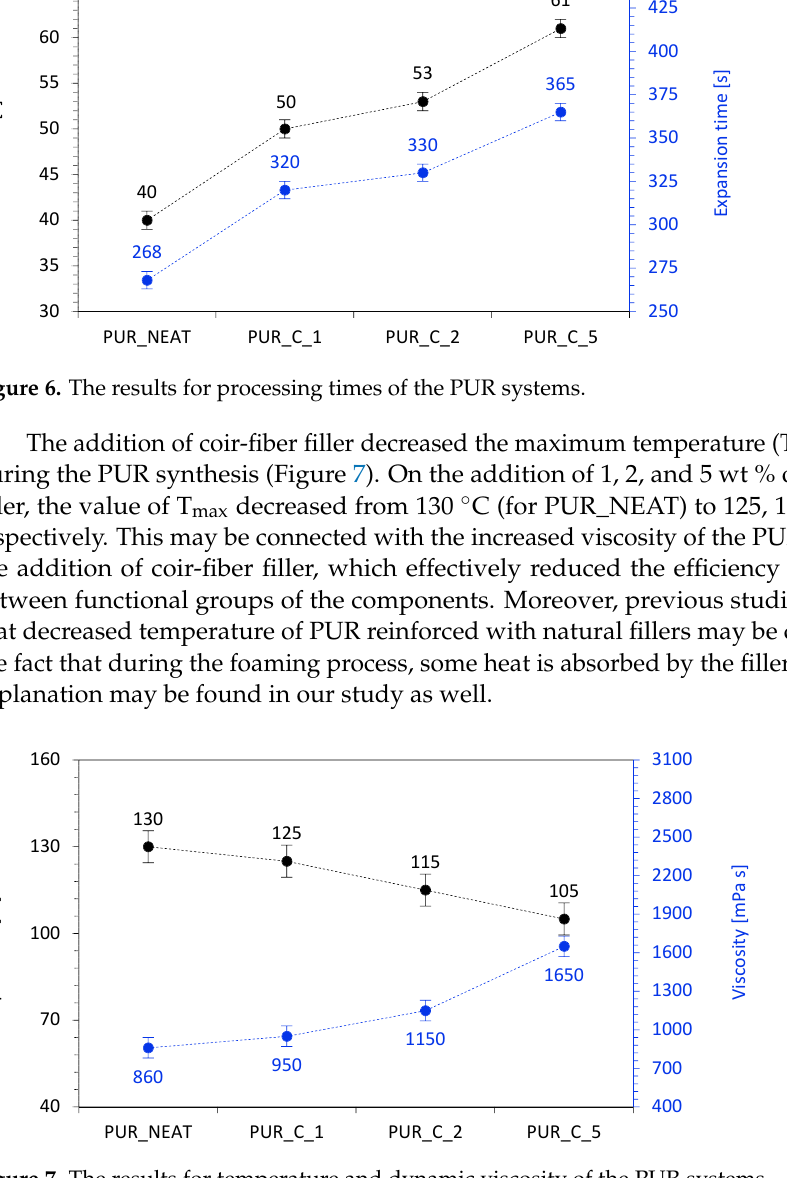
Figure 7. The results for temperature and dynamic viscosity of the PUR systems.